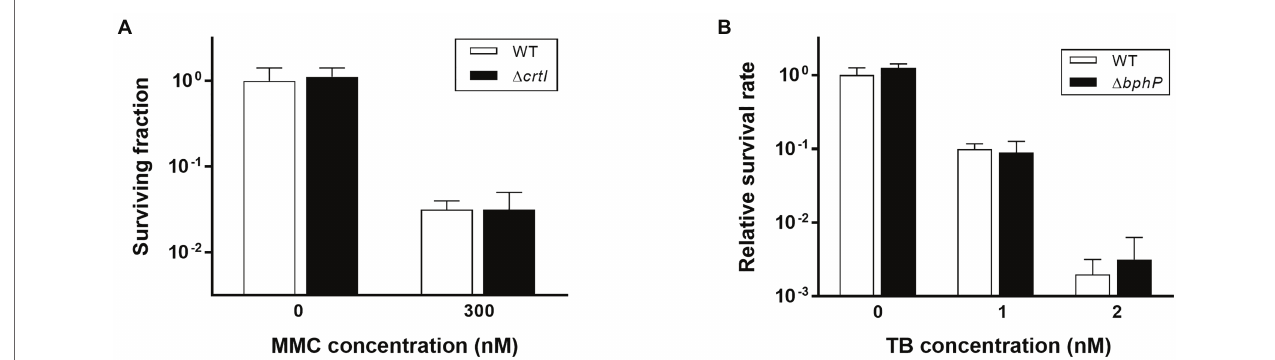
FIGURE 4 | Survival of Δ crtI during continuous exposure to MMC (A) and survival of Δ bphP during continuous exposure to toluidine blue (TB; B ). The D. radiodurans strains were grown to log phase and spotted on TGY plates supplemented with the indicated concentrations of MMC or TB. The plates were incubated under red light (700 nm) conditions for 2 days prior to the enumeration of colonies. The surviving fraction was expressed relative to non-treated WT survival (arbitrarily set at 1). The error bars represent the SD of three independent experiments ( n =